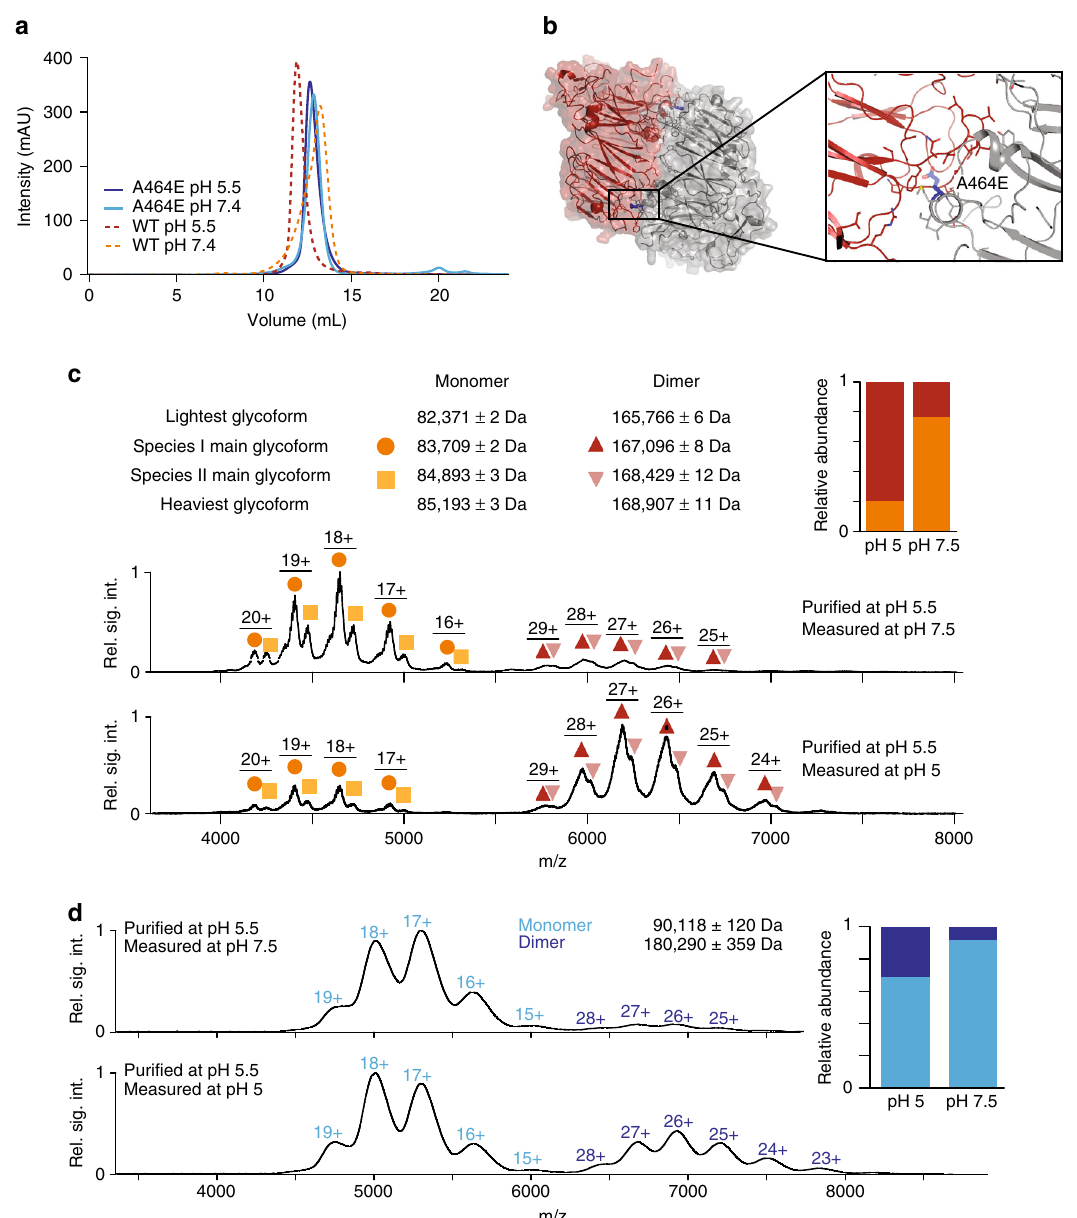
Fig. 4 Wt s-sortilin is in a pH-dependent dimerization equilibrium while dimerization interface mutant A464E is predominantly a monomer at acidic pH. a Superose 6 size exclusion chromatography traces show that wt s-sortilin appears larger (smaller retention volume) at pH 5.5 (red) than at pH 7.4 (orange), while there are no difference in retention volume between A464E at pH 5.5 (dark blue) and pH 7.4 (light blue). b Based on the s-sortilin dimer structure mutant A464E (stick representation, blue) was constructed to prevent dimer formation. The A464E mutation prevents hydrophobic interactions by introducing a charged residue. c Native MS of wt s-sortilin produced in HEK293-ES cells (resulting in shorter, more homogeneous oligomannose glycans) shows that at pH 5, s-sortilin is mainly present as a dimer, while at pH 7.5, s-sortilin is predominantly a monomer (wt s-sortilin produced in HEK293-E cells, resulting in larger, less homogeneous hybrid glycans, gives a similar result, Supplementary Fig. 5b). d Native MS of s-sortilin A464E produced in HEK293-E cells shows that both at pH 5 and pH 7.5, s-sortilin A464E is predominantly a